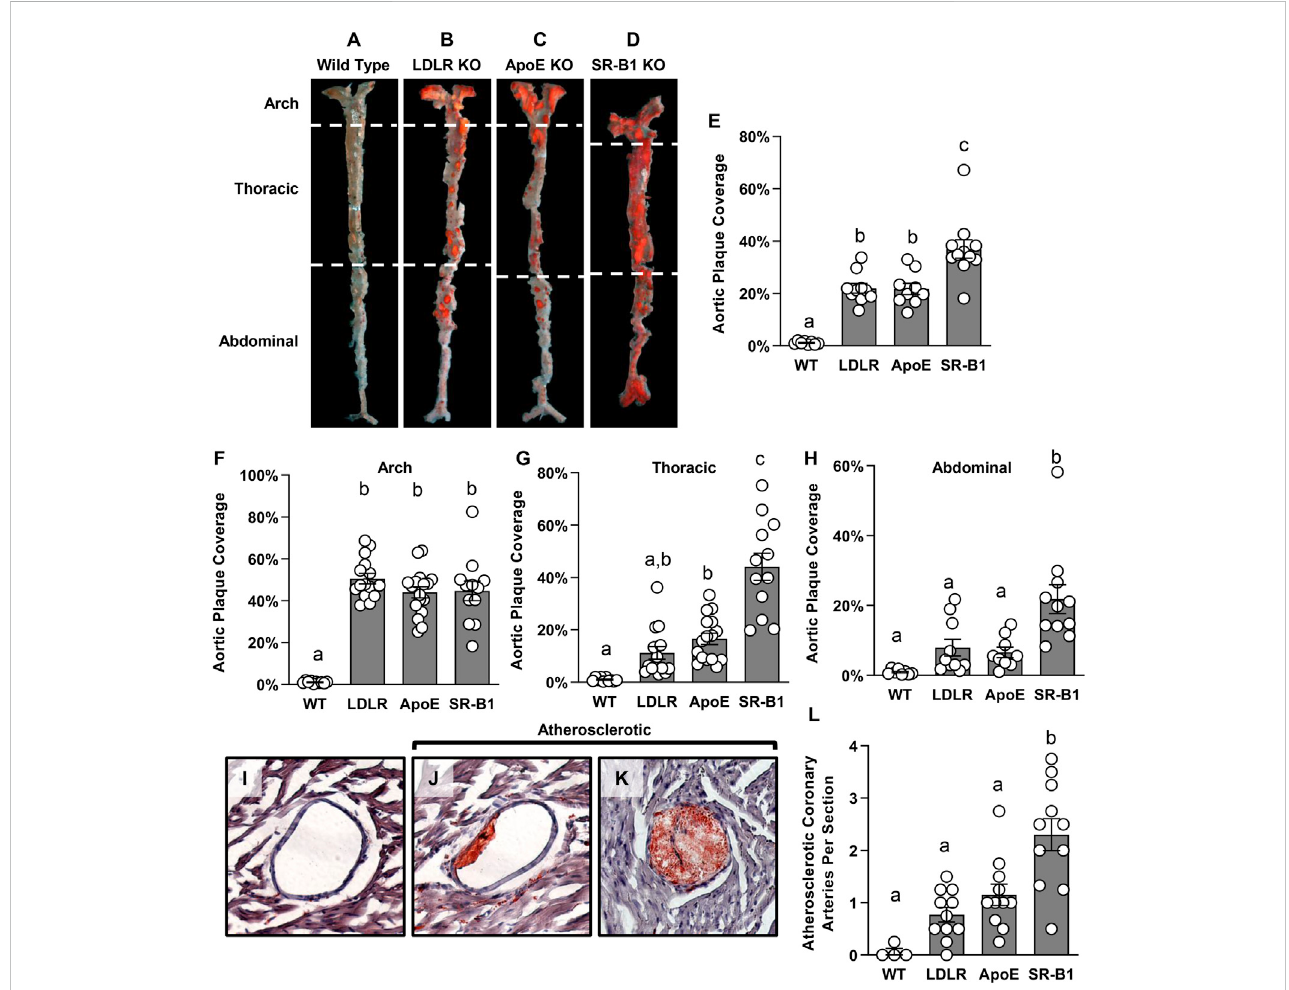
FIGURE 3 AtherosclerosisinthedescendingaortaandcoronaryarteriesofHFCC-fedfemaleWT,LDLRKO,ApoEKOandSR-B1KOmice. (A – D) Representativeen- face images of Sudan-IV-stained whole aortas from mice in the indicated genotype group. Dashed white lines indicate the boundaries of regions de fi ned as the aortic arch, thoracic aorta and abdominal aorta. (E – H) Plaque coverage as a percentage of entire en-face vessel area in the whole aorta (E) ( N = 8 – 11 per group), the aortic arch (F) ( N = 10 – 17 per group), the thoracic aorta (G) ( N = 10 – 16 per group) and the abdominal aorta (H) ( N = 8 – 11 per group). (I – K) Representative images of oil red-O-stained coronary arteries that are plaque free (I) or partially (J) or fully (K) occluded with atherosclerotic plaque. All coronary artery cross sections containing atherosclerotic plaques were counted in at least 3 transverse myocardial cross-sections spaced at least 0.5 mm apart from each mouse. The graph in (L) represents the average number of atherosclerotic coronary artery cross sections observed per myocardial cross- section ( N = 4 (WT) or 11 (LDLR KO, ApoE KO and SR-B1 KO). Individual symbols represent data from individual mice and bars with error bars represent average ± SEM of each group. The different letters indicate groups that are statistically signi fi cantly different from one another by one-way ANOVA with Tukey ’ spost-hoctest. (E) OverallANOVA: p < 0.0001;multiplecomparisons: p < 0.0001foravs . borc; (F) OverallANOVA: p < 0.0001;multiplecomparisons: p < 0.0001 for a vs. b; p < 0.006 for b vs. c; (G) Overall ANOVA: p < 0.0001; multiple comparisons: p = 0.005 for a vs. b; p < 0.0001 for c vs. a or b; (H) Overall ANOVA: p < 0.0001; multiple comparisons: p < 0.005 for a vs. b; (L) Overall ANOVA: p < 0.0001; multiple comparisons: p < 0.004 for a vs.